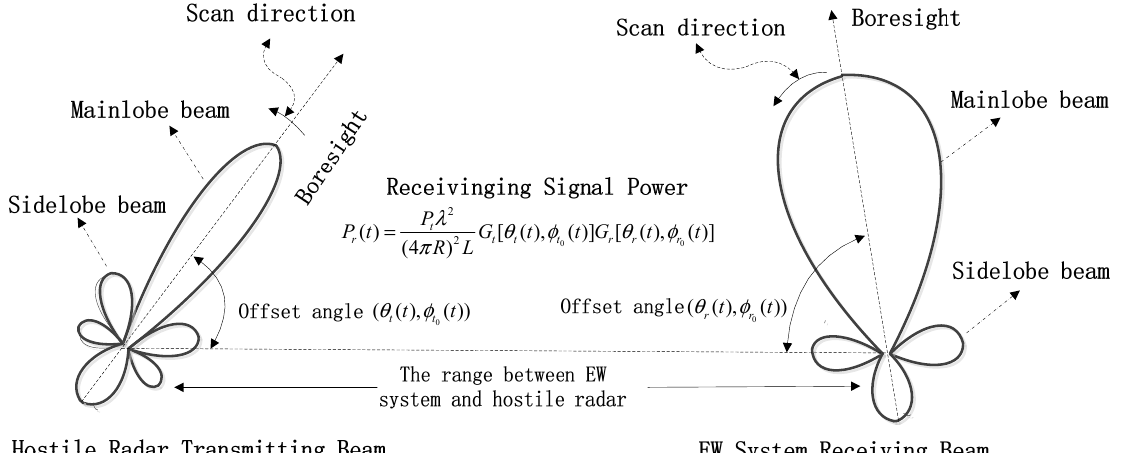
Figure 1. The models of circularly-scanning antennas of the radar and EW system. The antennas scan in the counter-clockwise direction; the radar transmitting beam is narrow, while the EW system receiving beam is wide. EW, electronic warfare.